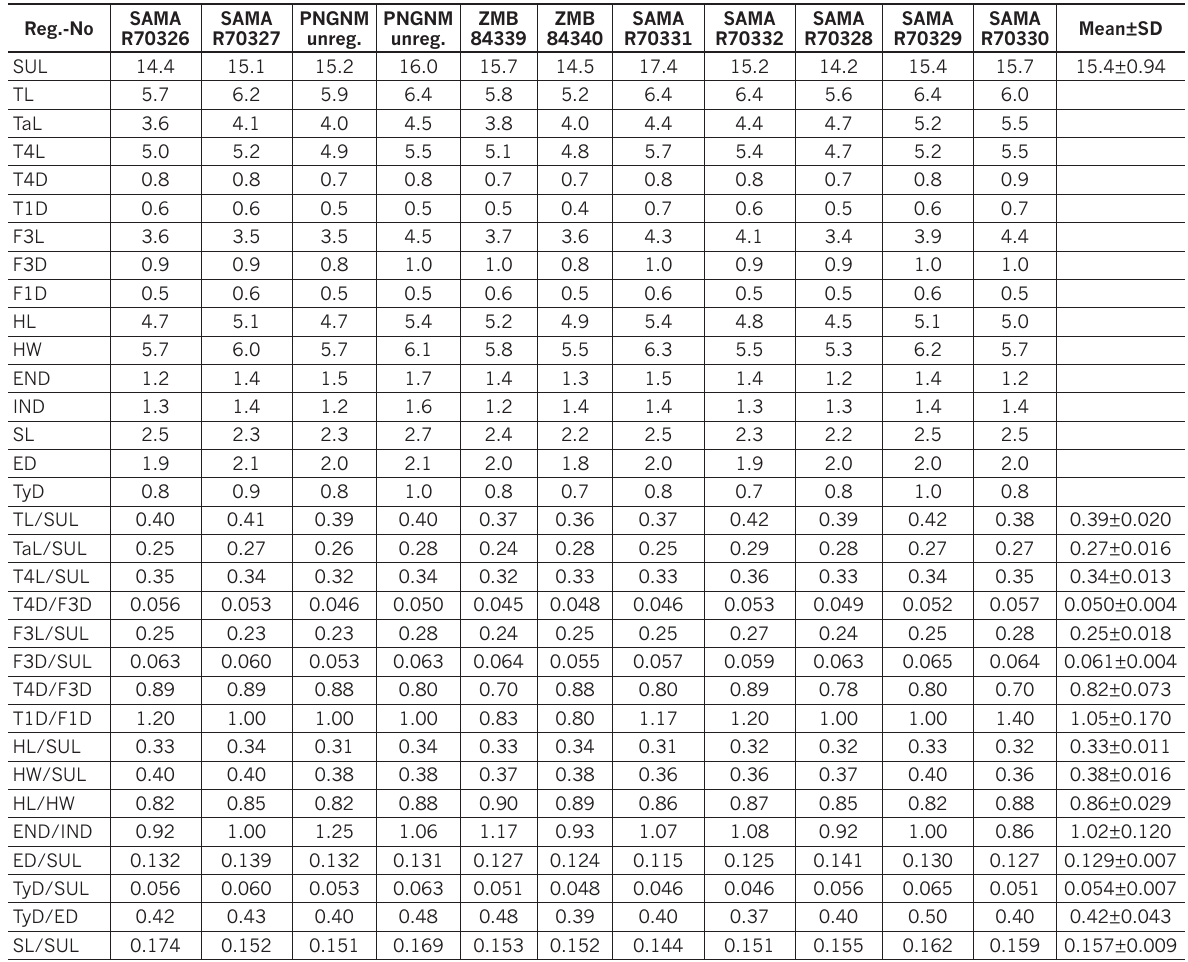
Table 3. Body measurements and body ratios of the type series of Choerophryne bisyllaba sp. n. SAMA R70326 is the holotype, all types are adult males, except SAMA R70332 which is a subadult (?) female; all measurements in mm. SAMA Reg.-No